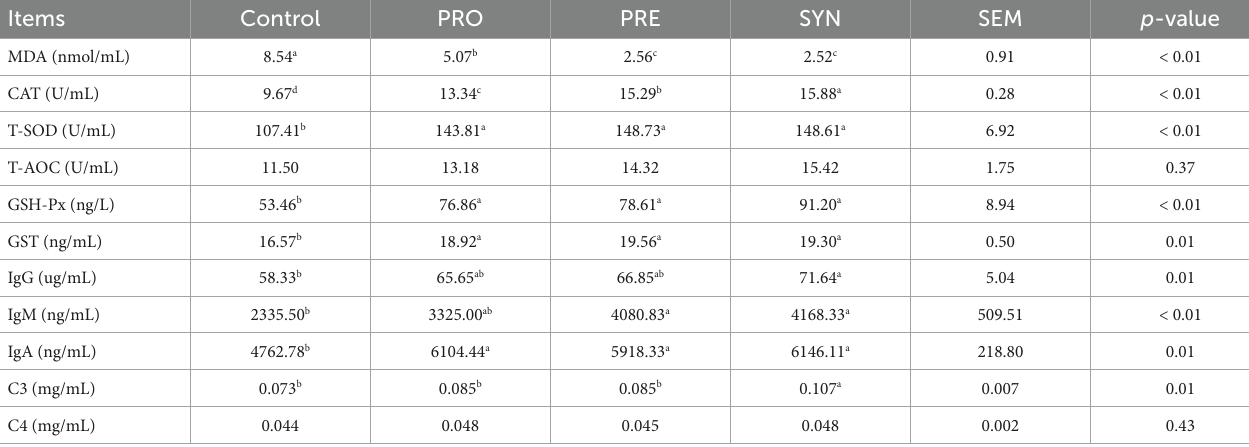
TABLE 5 Effects of dietary treatments on the serum antioxidant and immune capacity of laying hens. Items